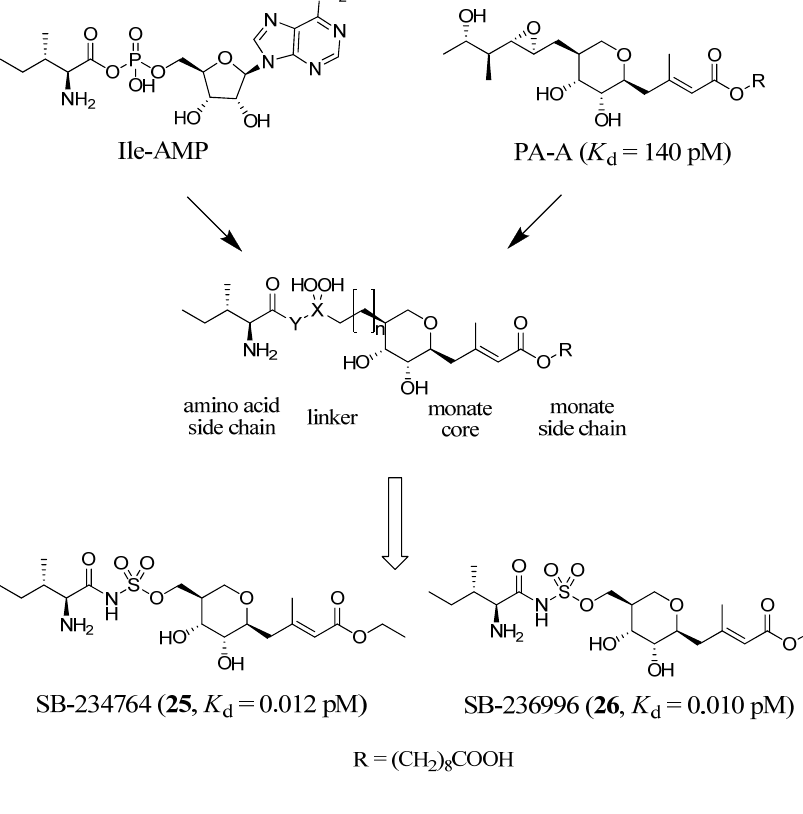
Figure 10. Inhibitor design scheme of Brown et al. (2000) for IleRS